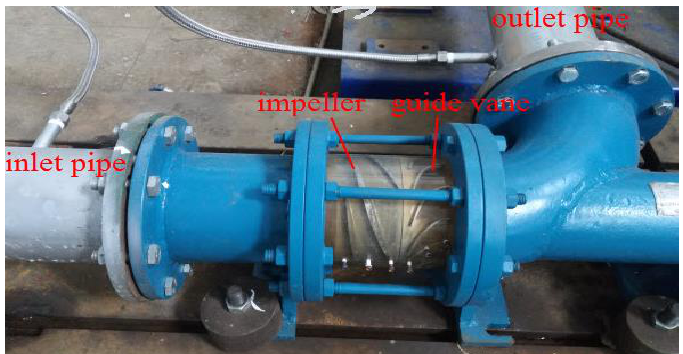
Figure 2. Test pump model.